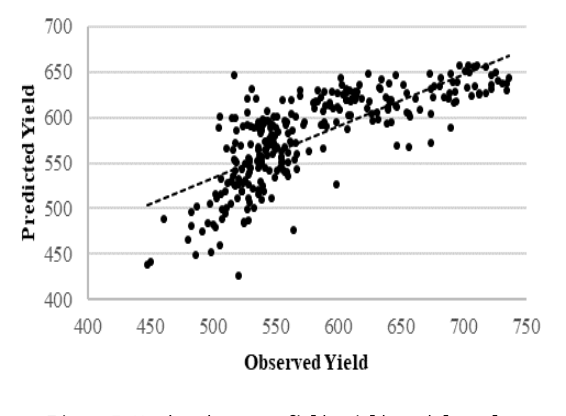
Figure 7. Norkotah potato fields yield model